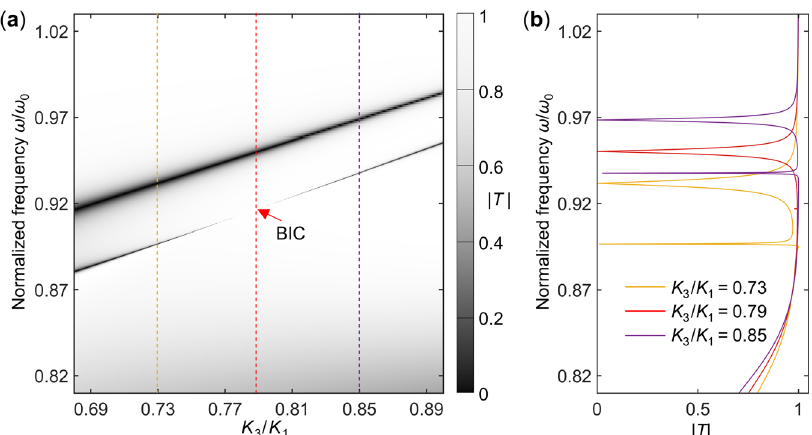
Fig. 7 Zoomed-in view of the BIC and sharp resonances. a Zoomed-in view of the bound-states-in-the-continuum (BIC) point highlighted by the yellow box in Fig. 6a. b Cuts through the data in panel a at three selected ratios K 3 = K 1 (see dashed vertical lines in a ).